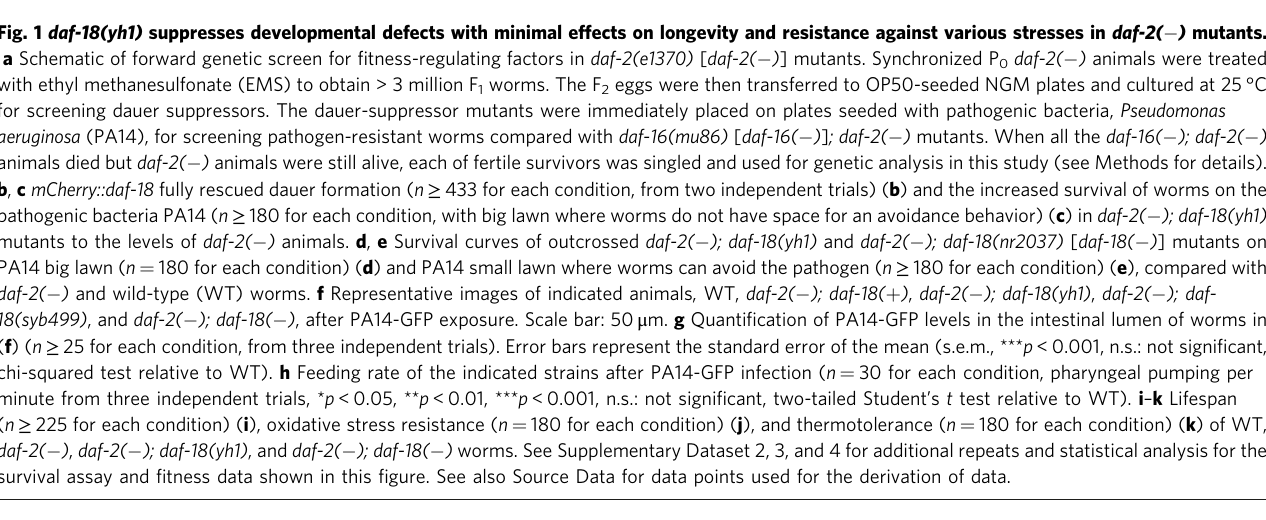
Fig. 1 daf-18(yh1) suppresses developmental defects with minimal effects on longevity and resistance against various stresses in daf-2( − ) mutants. a Schematic of forward genetic screen for fi tness-regulating factors in daf-2(e1370) [ daf-2( − ) ] mutants. Synchronized P 0 daf-2( − ) animals were treated with ethyl methanesulfonate (EMS) to obtain > 3 million F 1 worms. The F 2 eggs were then transferred to OP50-seeded NGM plates and cultured at 25 °C for screening dauer suppressors. The dauer-suppressor mutants were immediately placed on plates seeded with pathogenic bacteria, Pseudomonas aeruginosa (PA14), for screening pathogen-resistant worms compared with daf-16(mu86) [ daf-16( − ) ] ; daf-2( − ) mutants. When all the daf-16( − ); daf-2( − ) animals died but daf-2( − ) animals were still alive, each of fertile survivors was singled and used for genetic analysis in this study (see Methods for details). b , c mCherry::daf-18 fully rescued dauer formation ( n ≥ 433 for each condition, from two independent trials) ( b ) and the increased survival of worms on the pathogenic bacteria PA14 ( n ≥ 180 for each condition, with big lawn where worms do not have space for an avoidance behavior) ( c ) in daf-2( − ); daf-18(yh1) mutants to the levels of daf-2( − ) animals. d , e Survival curves of outcrossed daf-2( − ); daf-18(yh1) and daf-2( − ); daf-18(nr2037) [ daf-18( − ) ] mutants on PA14 big lawn ( n = 180 for each condition) ( d ) and PA14 small lawn where worms can avoid the pathogen ( n ≥ 180 for each condition) ( e ), compared with daf-2( − ) and wild-type (WT) worms. f Representative images of indicated animals, WT, daf-2( − ); daf-18( + ) , daf-2( − ); daf-18(yh1) , daf-2( − ); daf- 18(syb499) , and daf-2( − ); daf-18( − ) , after PA14-GFP exposure. Scale bar: 50 μ m. g Quanti fi cation of PA14-GFP levels in the intestinal lumen of worms in ( f ) ( n ≥ 25 for each condition, from three independent trials). Error bars represent the standard error of the mean (s.e.m., *** p < 0.001, n.s.: not signi fi cant, chi-squared test relative to WT). h Feeding rate of the indicated strains after PA14-GFP infection ( n = 30 for each condition, pharyngeal pumping per minute from three independent trials, * p < 0.05, ** p < 0.01, *** p < 0.001, n.s.: not signi fi cant, two-tailed Student ’ s t test relative to WT). i – k Lifespan ( n ≥ 225 for each condition) ( i ), oxidative stress resistance ( n = 180 for each condition) ( j ), and thermotolerance ( n = 180 for each condition) ( k ) of WT, daf-2( − ) , daf-2( − ); daf-18(yh1) , and daf-2( − ); daf-18( − ) worms. See Supplementary Dataset 2, 3, and 4 for additional repeats and statistical analysis for the survival assay and fi tness data shown in this fi gure. See also Source Data for data points used for the derivation of